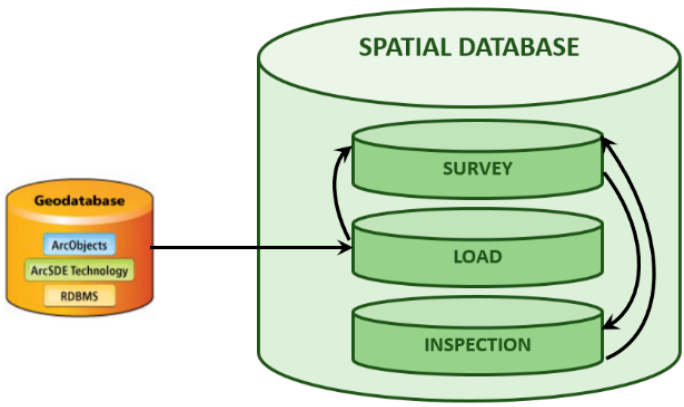
Figure 9. Spatial database schemes.